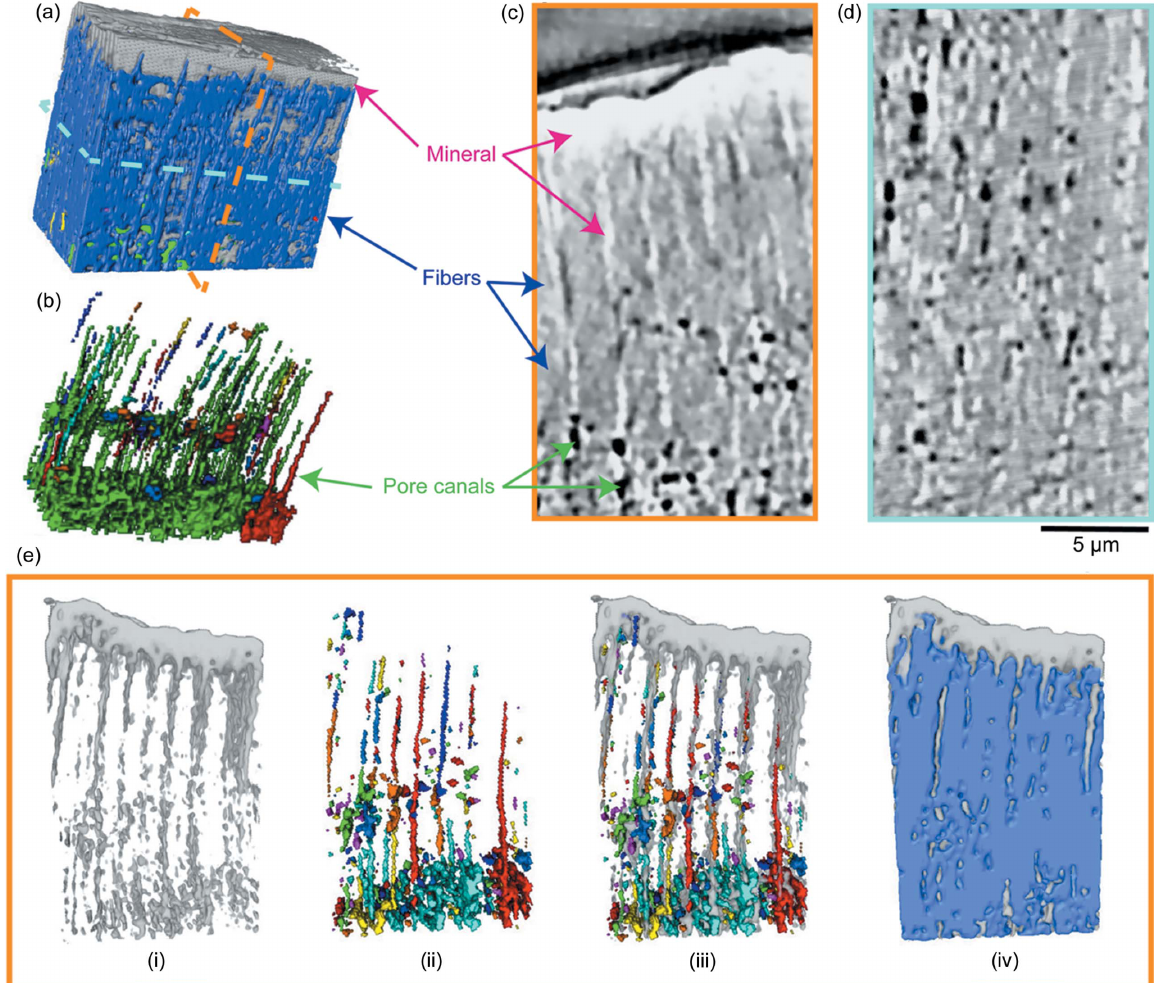
Figure 5 3D architecture of the impact surface and impact region revealed by nano-CT characterization. ( a ) Highly interpenetrated 3D structure consisting of three main segments: mineral nanoparticle aggregation, chitin fiber scaffold and pore canal network. ( b ) 3D model of pore canal network. ( c )–( d ) Slices of CT scan acquired from perpendicular projections (white regions represent mineral particles, gray regions represent chitin fiber bundles and black regions represent pore canals.). ( e ) 3D rendering of interest volume. The distributions of pore canals ( e -ii) and minerals are highly correlated ( e -iii) shown in colored CT slices, with ( e -i) showing a representation of the mineral particle distribution; ( e -iv) shows the interlocking structural design of mineral particles and fiber bundles in the impact surface and impact